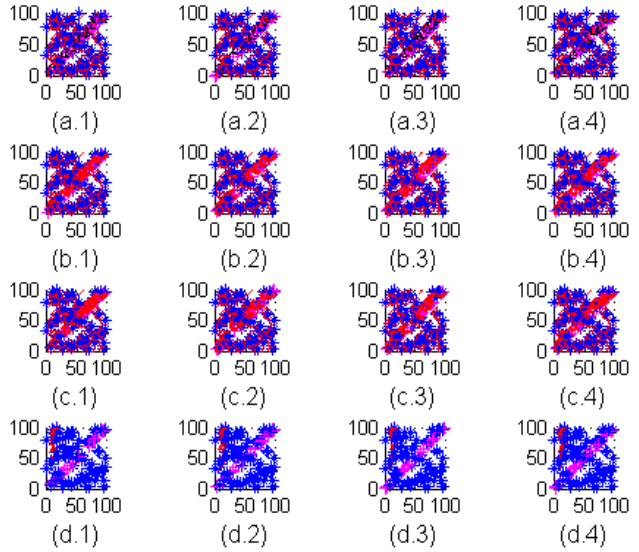
Figure 2. Best solutions of ABC: ( a.1 ) iteration #50, ( a.2 ) iteration #100, ( a.3 )